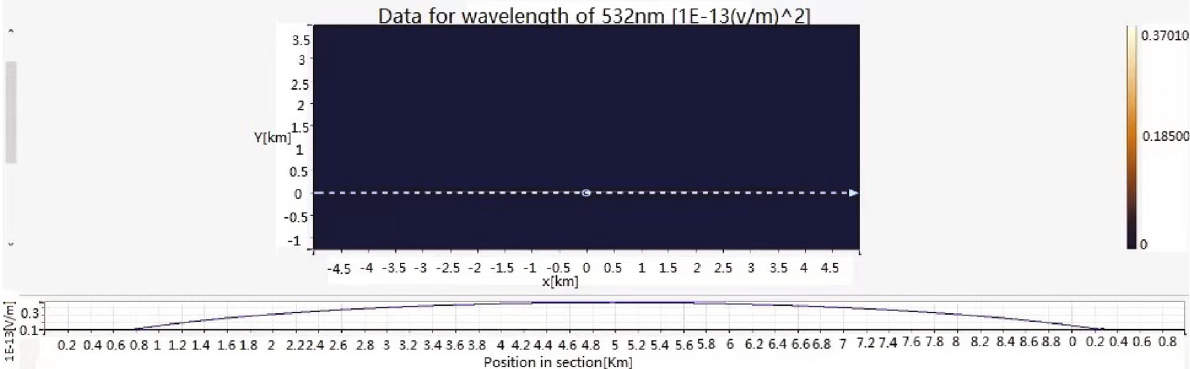
Figure 11: Laser illumination statistics on the position of Z = 500